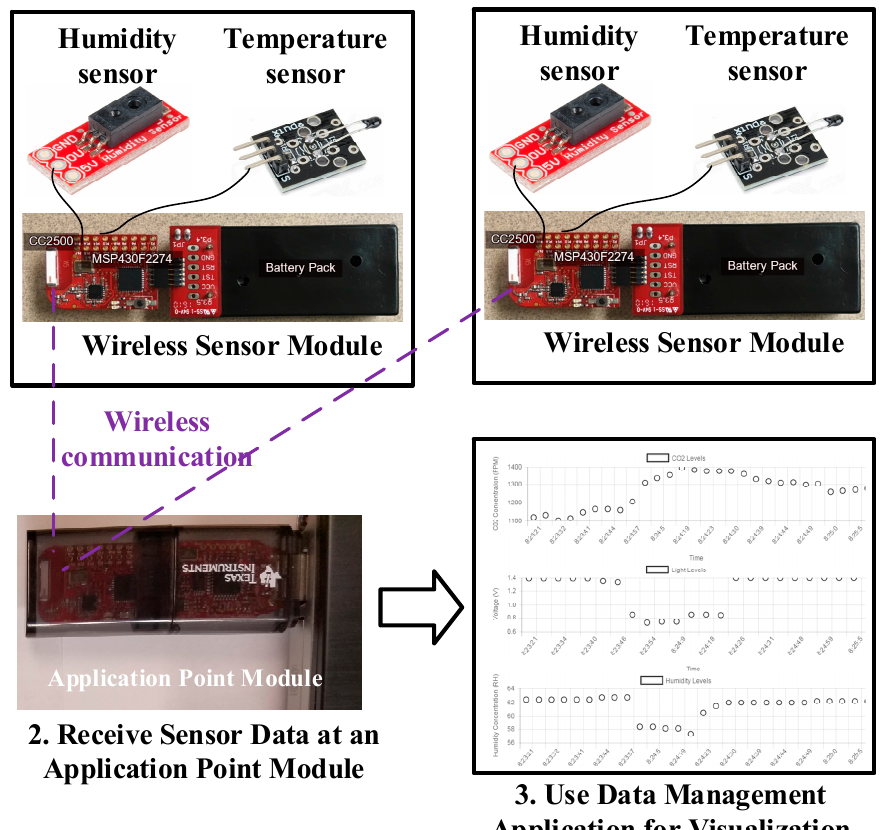
Figure 3. Illustration of the entire wireless sensor network (WSN) system operation.